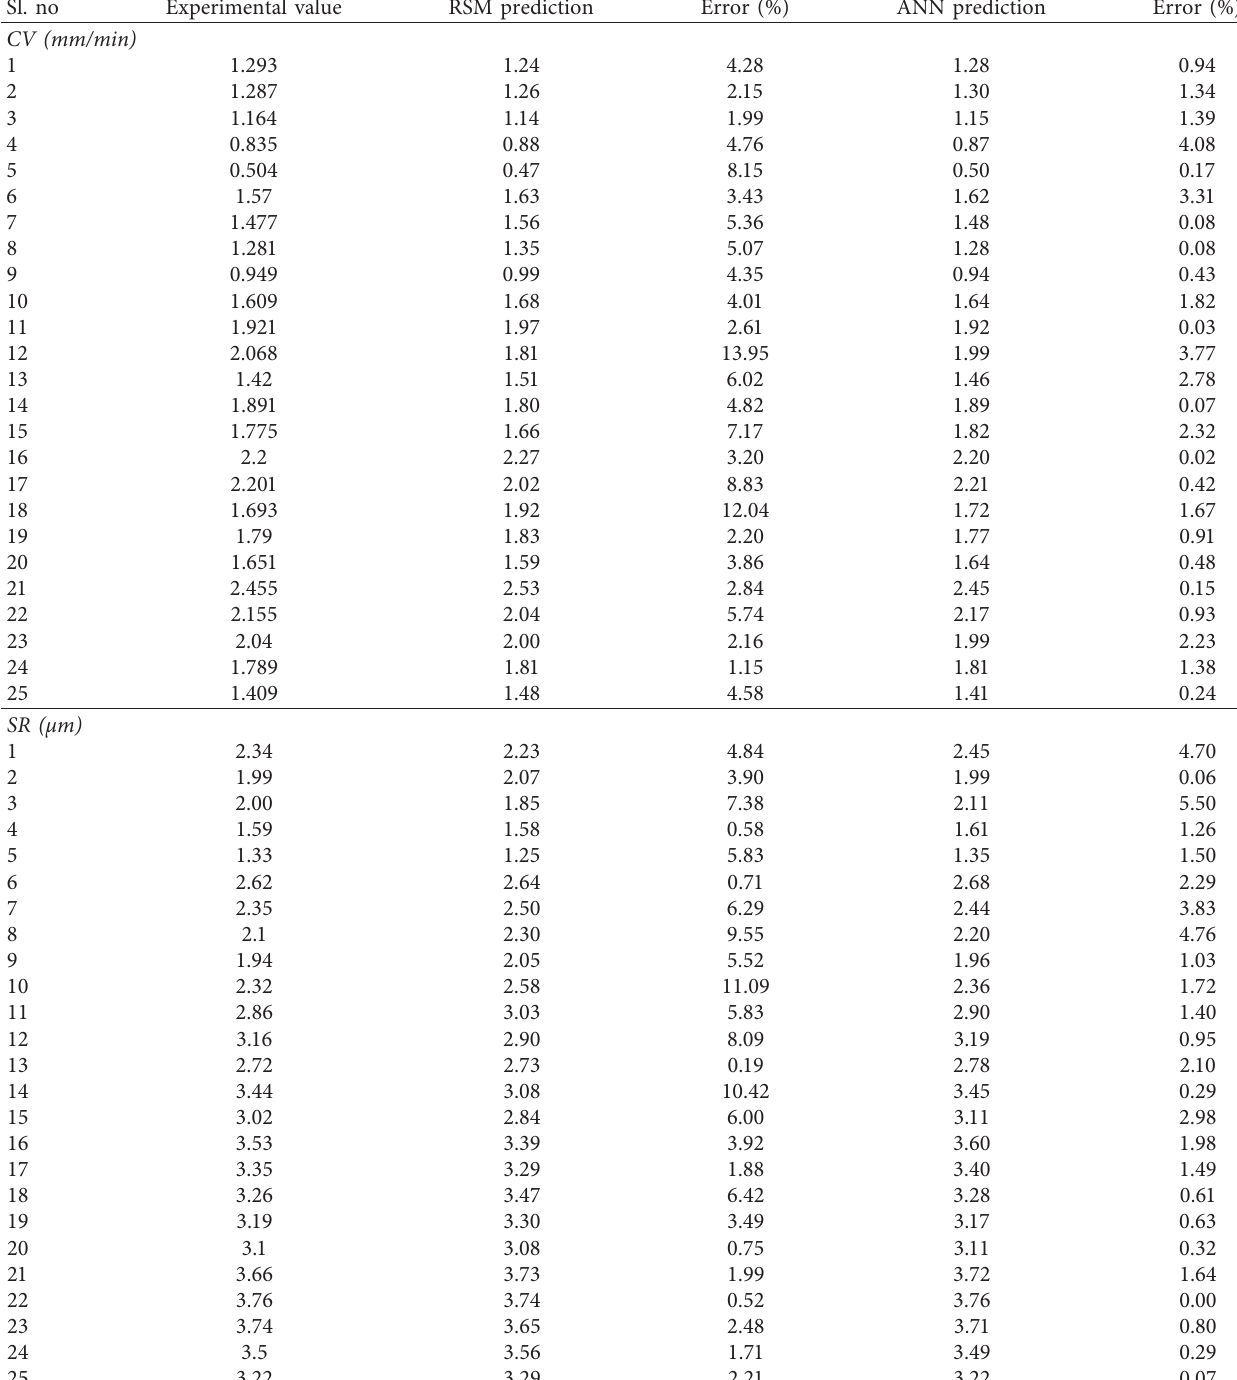
Table 6: Prediction of cutting velocity and surface roughness by RSM and